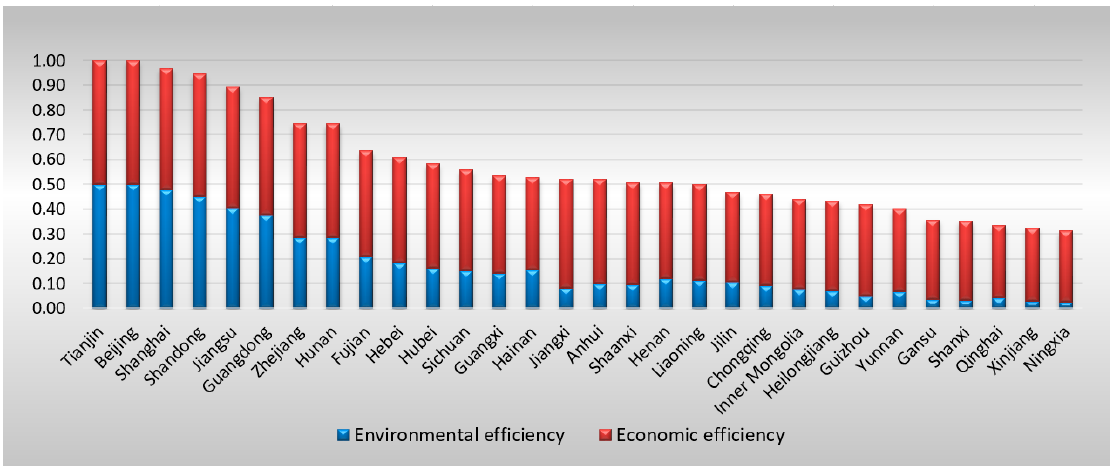
Figure 3. Average original EEE for provinces (2012–2016) in Stage 1. Source: Drafted by authors.